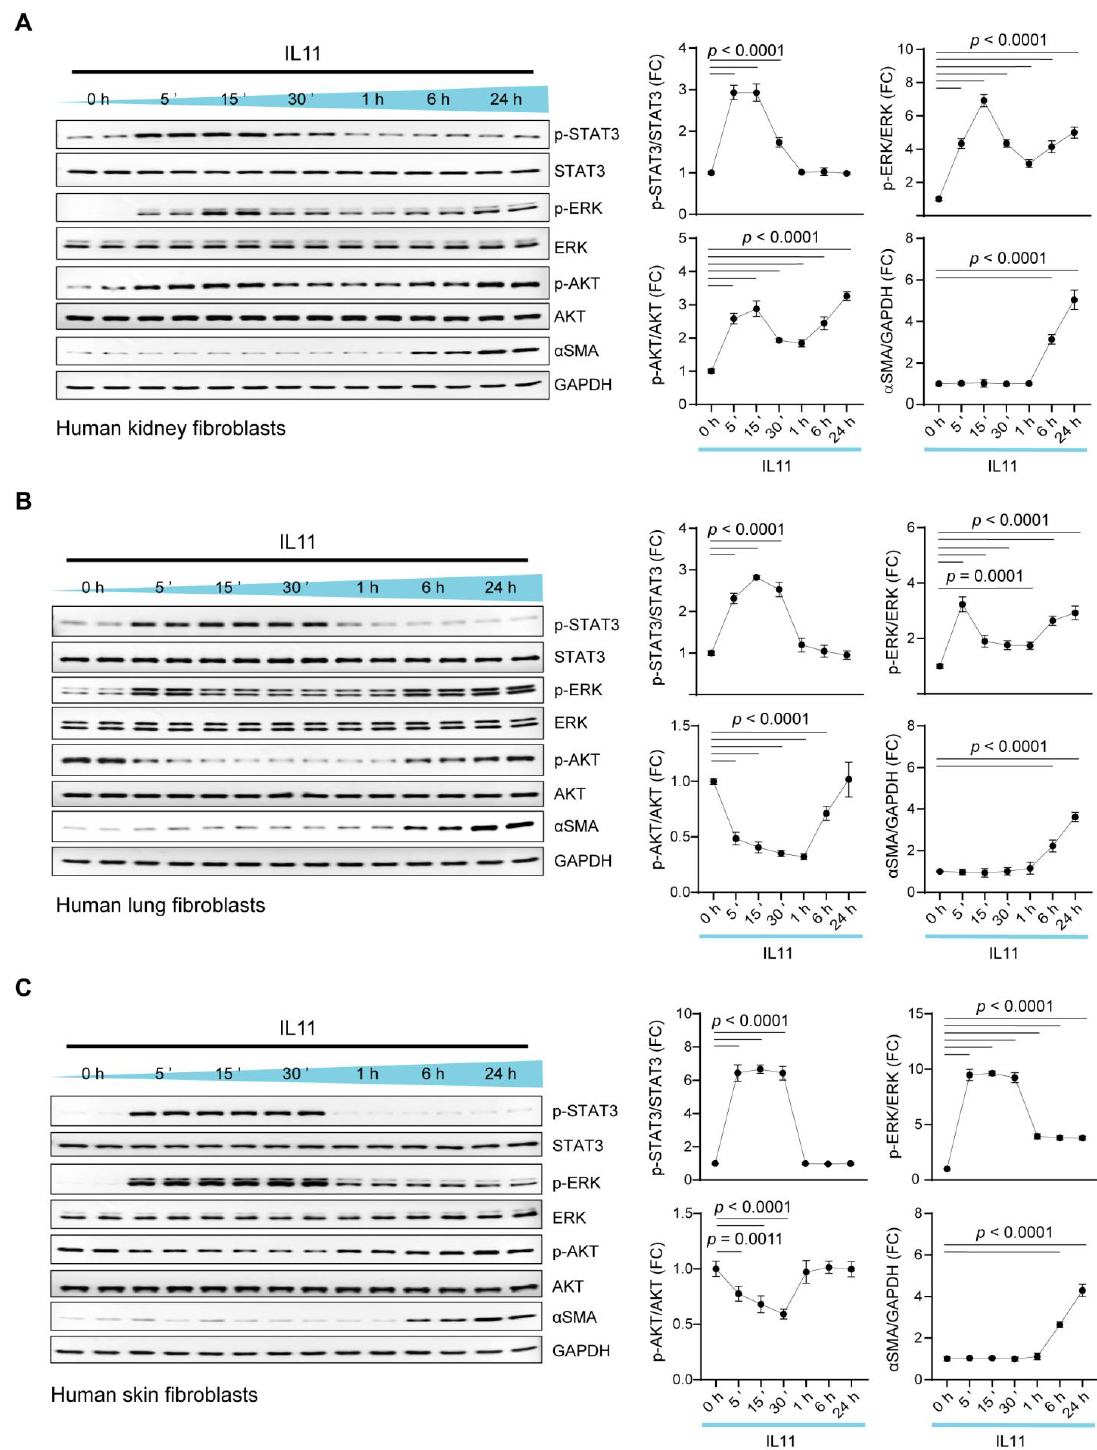
Figure 1. IL11 induces transient and early STAT3 phosphorylation but sustains ERK activation in fibroblasts from three different organs. Western blots (WB) and densitometry analyses of p-STAT3, STAT3, p-ERK, ERK, p-AKT, AKT, α SMA and GAPDH in IL11 (10 ng/mL)-stimulated primary human ( A ) kidney fibroblasts (HKFs), ( B ) lung fibroblasts (HLFs) and ( C ) skin fibroblasts (HSFs) across time points (5 m—24 h). Data are shown as mean ± SD; one-way ANOVA with Dunnett’s correction (n = 4 biological replicates), FC: Fold